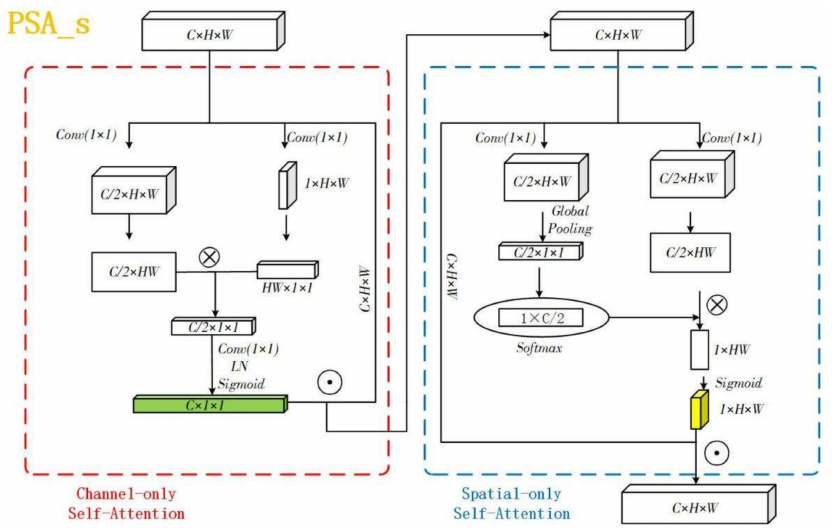
Figure 3. The attention mechanism PSA_s module. Channel-only Self-attention in the left half and Spatial-only Self-attention in the right half are connected in series. LN is layer normalization. ⊗ is matrix